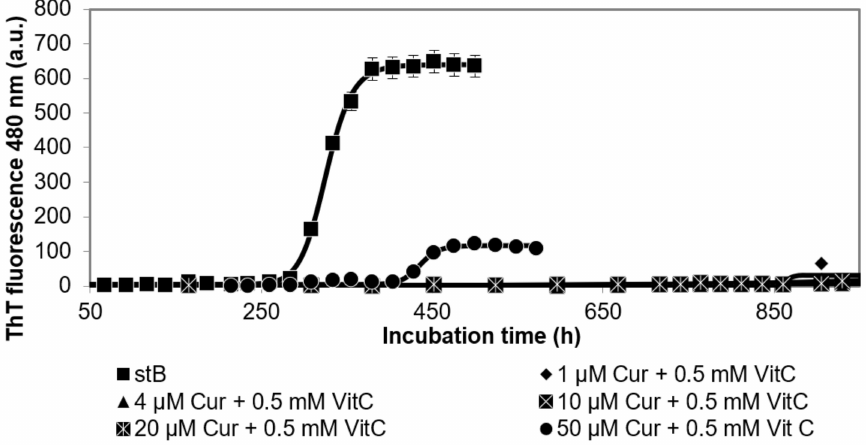
Figure 1. Time course of ThT fluorescence intensity following the amyloid fibril formation of stB in presence of curcumin (Cur). Different concentrations of Cur (as indicated) were added, while vitC concentration was kept constant at 0.5 mM.